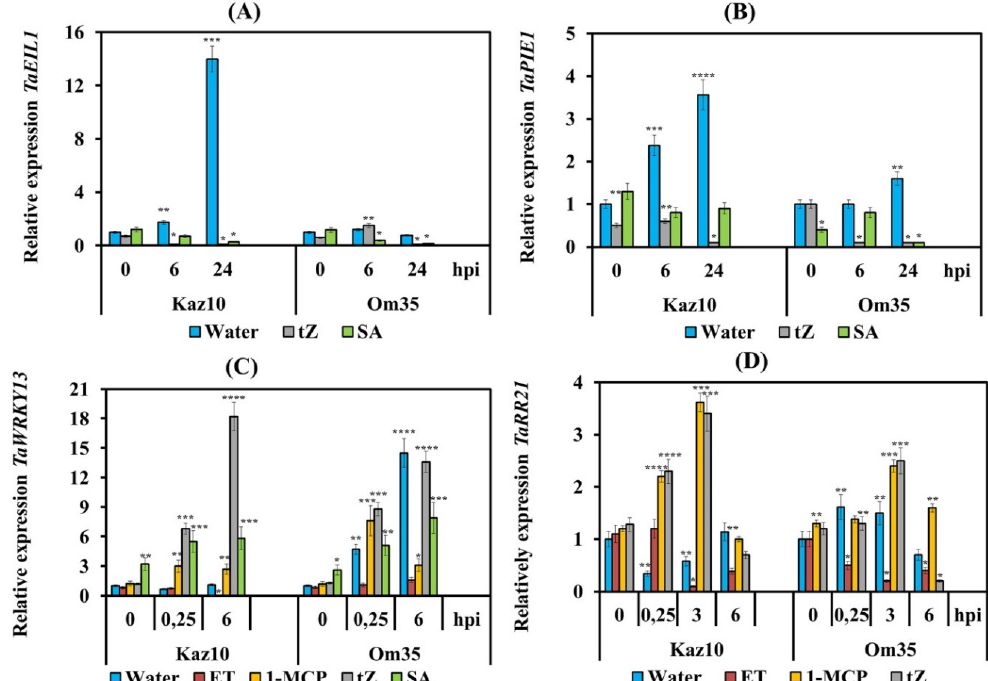
Figure 9. Interaction of signaling pathways of ethylene, cytokinin (CK) and SA in two wheat cultivars of Kaz10 and Om35 infected with virulent SnB. ( A ) The effect of pretreatment with tZ and SA on the relative expression of the TaEIL1 gene. ( B ) TaPIE1 gene. ( C ) The effect of pretreatment with ET, 1-MCP, tZ, and SA on the relative expression of the TaWRKY13 gene. ( D ) TaRR21 gene. Expression values are normalized to the housekeeping gene TaRLI as an internal reference and expressed relative to the normalized expression levels in mock-treated control (water) plants at 0 hpi. Symbols are the same as in Figures 2 and 5. Figures present means ± SE (n = 6). Asterisks indicate means statistically different from the control and different number of asterisks allows (*, **, ***, ****) distinguishing of significantly different variants according to the LSD test at * p < 0.05, ** p < 0.01, *** p < 0.001, **** p < 0.0001.